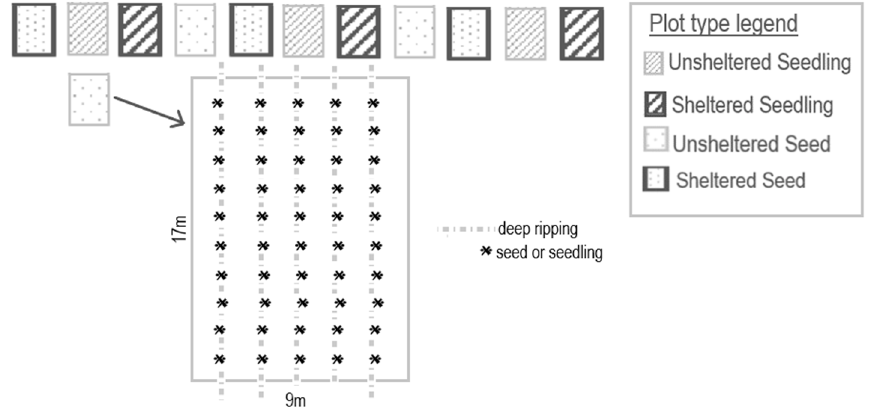
Figure 1. Plot layout of the research site. Each treatment combination had three replicate plots, and each plot contained 50 seedlings or seeds.